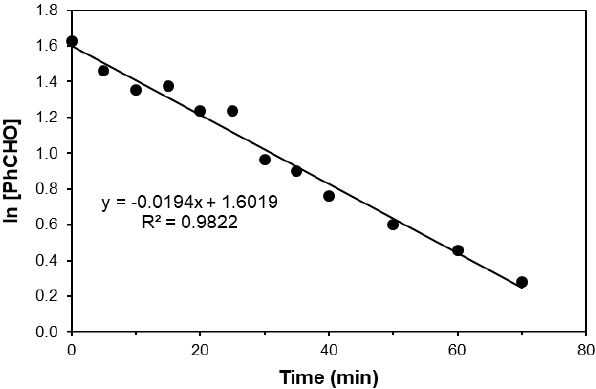
Figure 6. First-order plot ln([PhCHO]/[PhCHO] o ) = –k ald t for aerobic oxidation of PhCHO (4.9 mmol) catalyzed by HPA-1 (0.10 g, 0.048 mmol) at 100 °C, 0.50 mmol DBT, 10 mL dodecane, 20 mL min −1 air flow, 1300 rpm stirring speed; k ald = 0.019 min −1 .